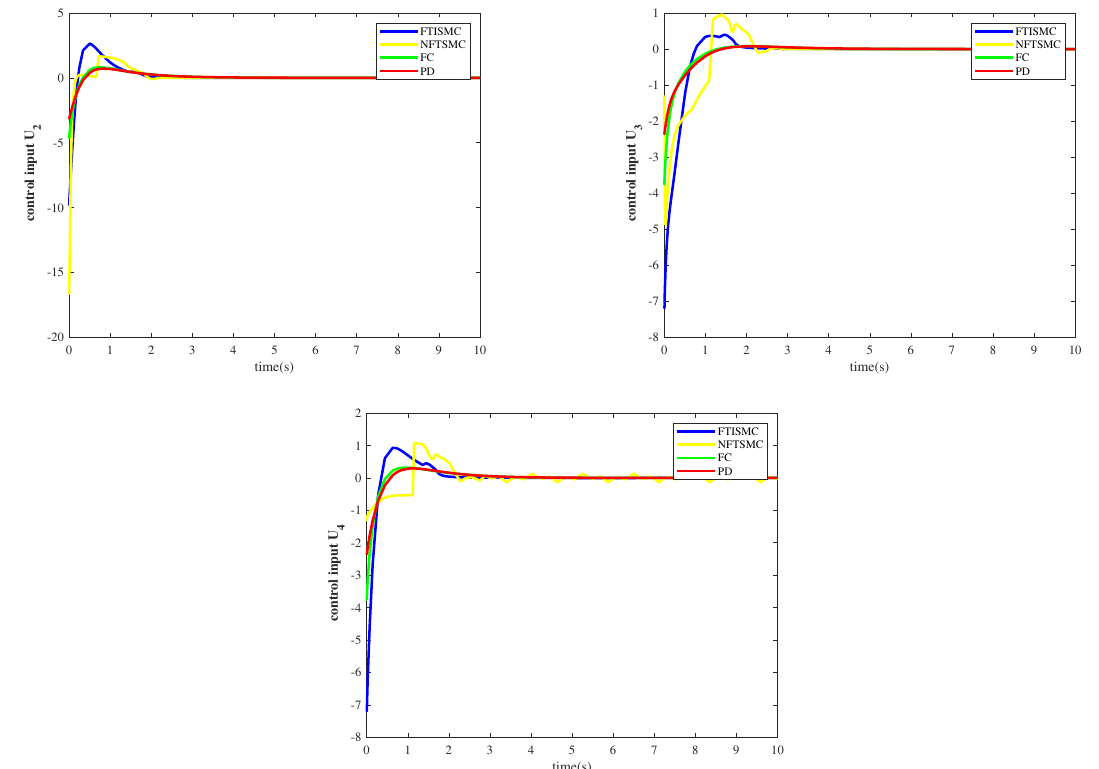
Figure 5. Control inputs of different